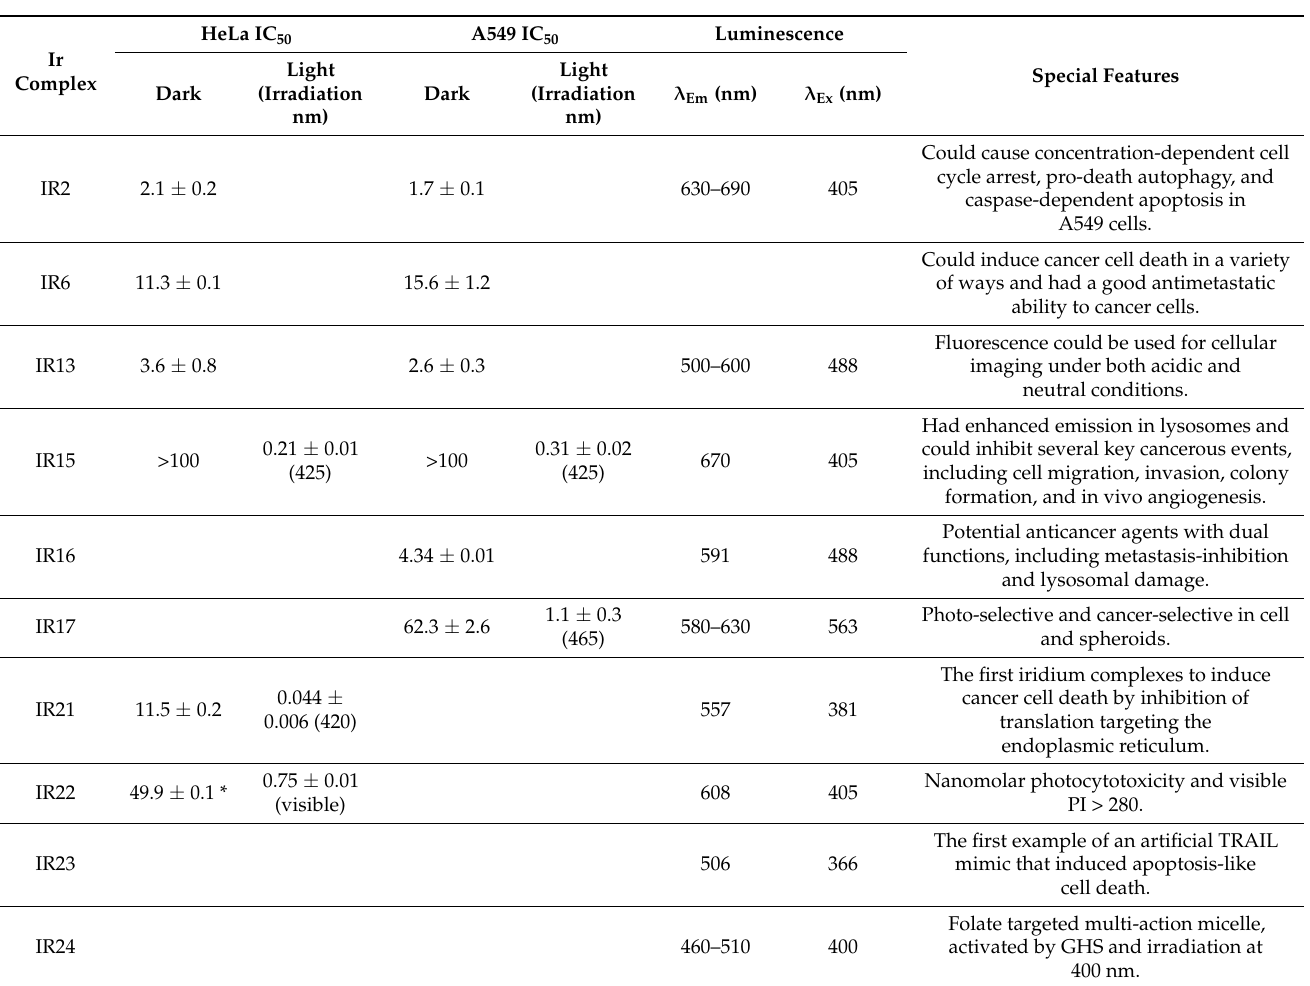
Table 1. A summary of IC 50 values, luminescent properties, and special features of iridium complexes: half sandwich complex IR13, where NˆN = L1 [34]; half sandwich complex IR6, where NˆN = L2 [24]; cyclometallated complexes IR2 [19], IR15 [37], IR16 [38], IR5 [39], IR21 [46]; dinuclear iridium(III) complex IR22 [47]; TRAIL-mimicking peptide complex IR23 [48]; and micelle multi-action prodrug IR24